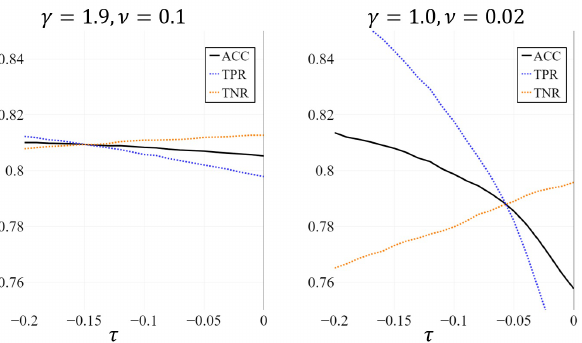
Figure 7. Performance rate as function of τ for fixed γ and ν . We show the results of ( γ = 1.9, ν = 0.1) and ( γ = 1.0, ν = 0.02).